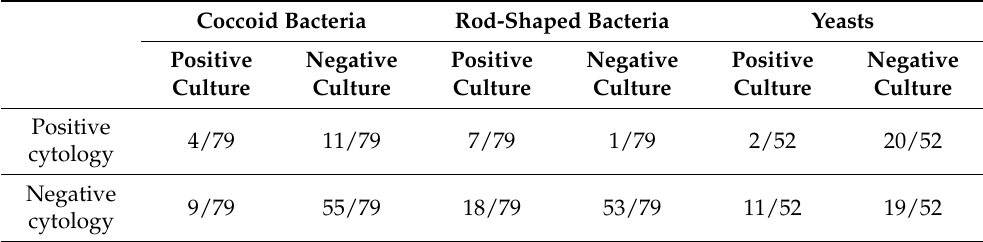
Table 1. Contingency table showing the results of cytology and bacterial and fungal cultures per- formed on dogs with erythemato-ceruminous otitis externa cleaned with the tested ear cleanser. Results obtained on D0 and D14 are pooled. Coccoid Bacteria Rod-Shaped Bacteria Yeasts Positive Negative Positive Culture Positive